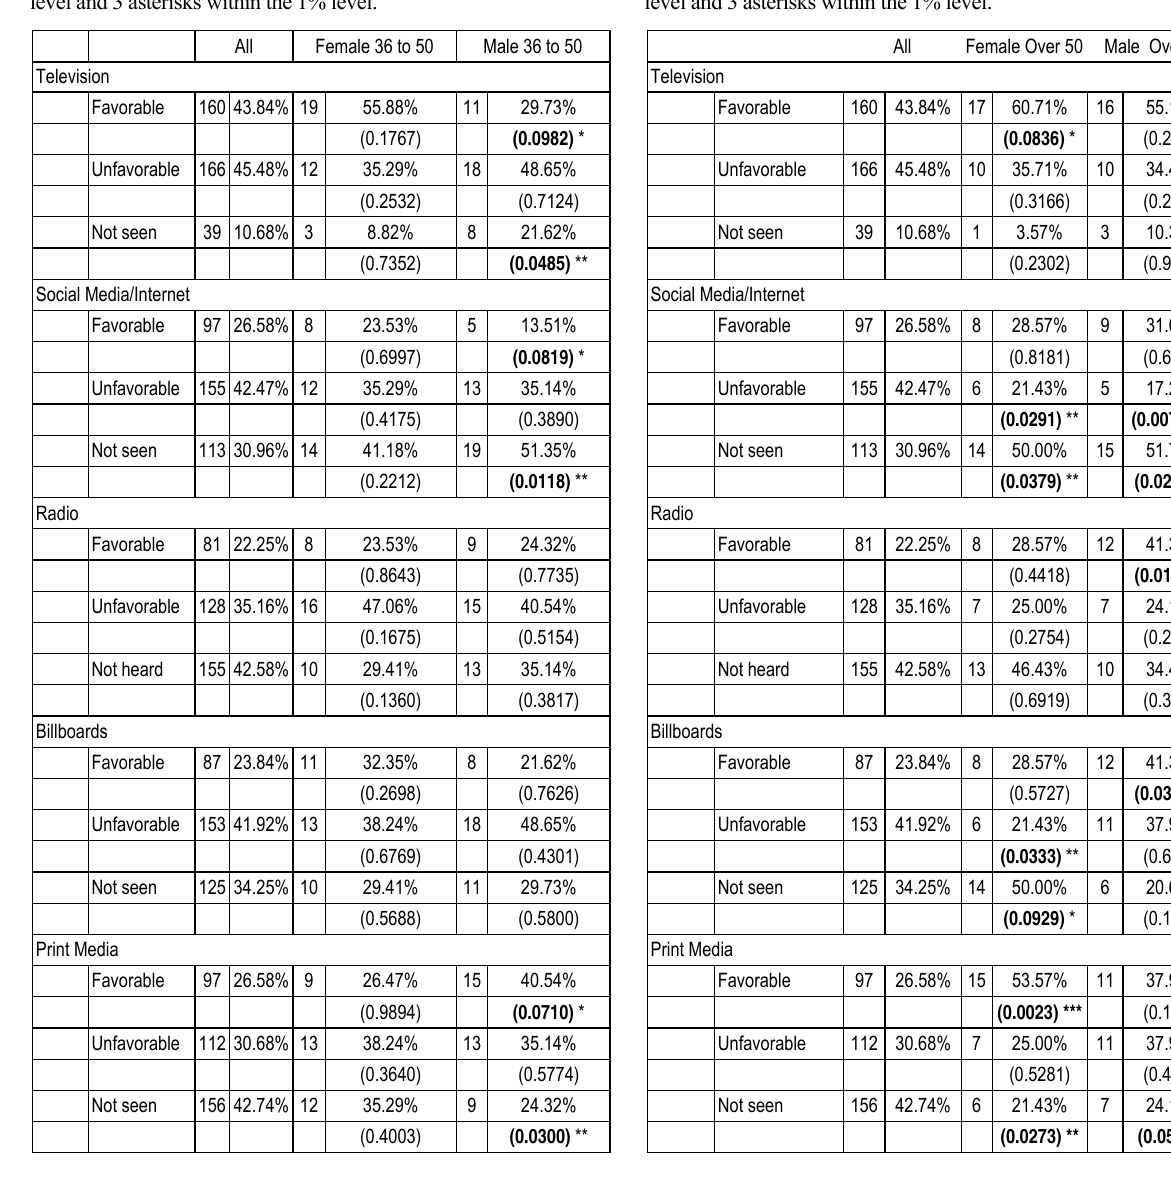
Table 3 (cont.). Compare male and female by age This table shows the overall results and the results by gender for specific age groups that had significant differences. The table shows the total number of respondents for each category per question and the percent. The number in the parenthesis is the probability that the percentage responses are statistically significantly different from the overall survey responses based on a Chi-square statistic. One aste- risk indicates significance at the 10% level, two asterisks at the 5% level and 3 asterisks within the 1% level.